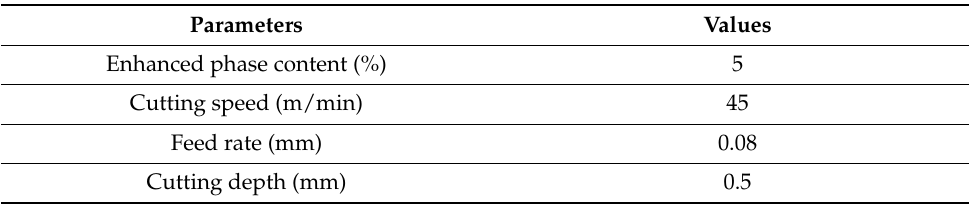
Table 6. Turning cutting parameters.